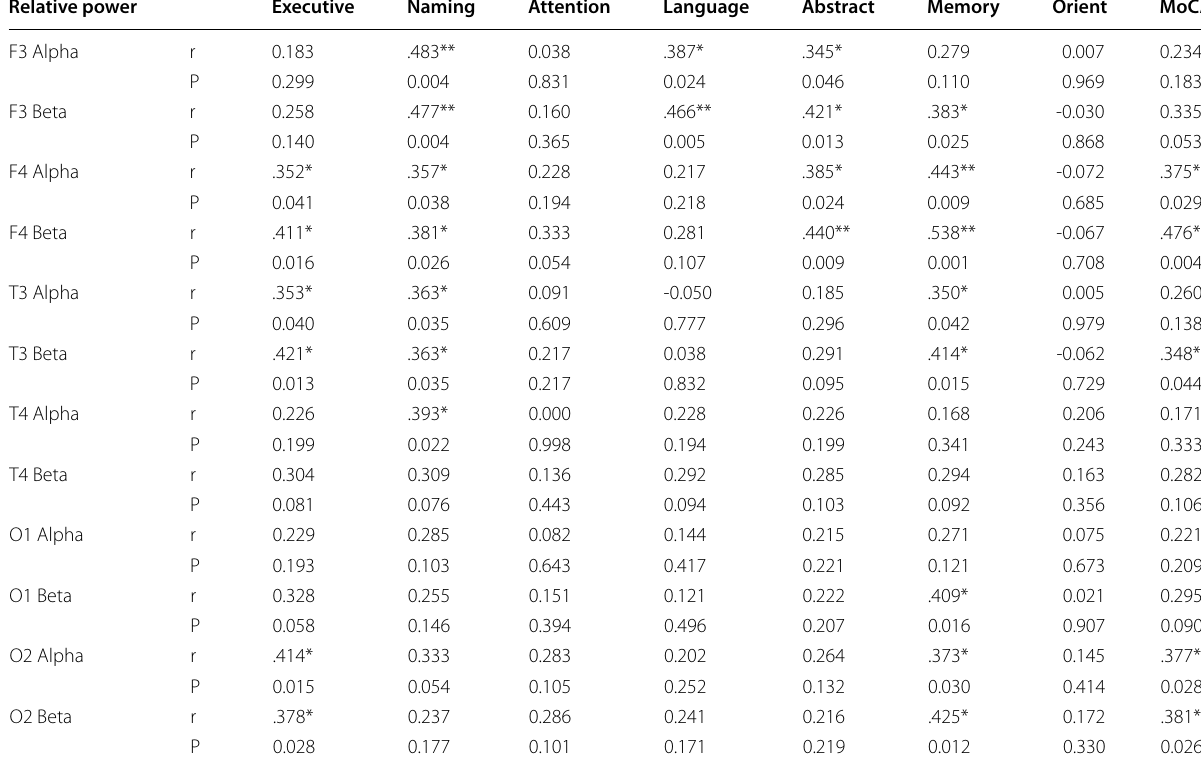
MoCA Montreal Cognitive Assessment; r correlation coefficient Spearman correlation *correlation is significant at the 0.05 level, **correlation is significant at the 0.01 level